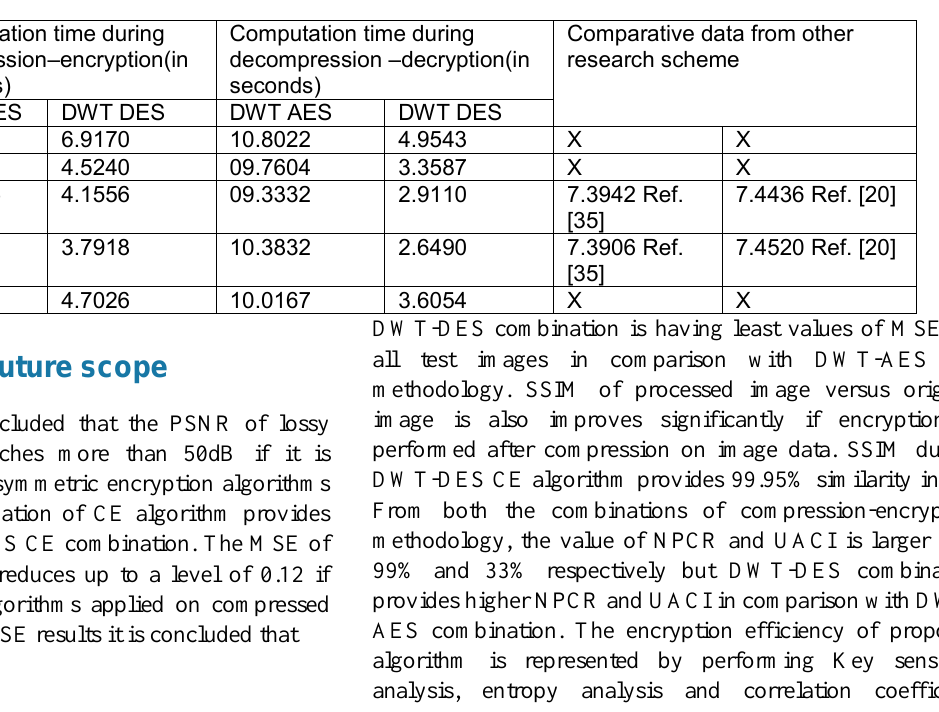
Table 10. Comparison of Computation time for different encryption